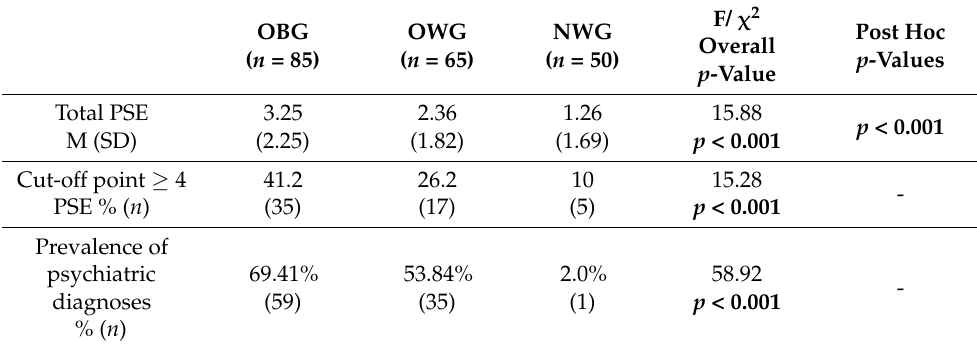
Table 2. Accumulation of Psychosocial Stress Events (PSEs) and differences in children by weight status.